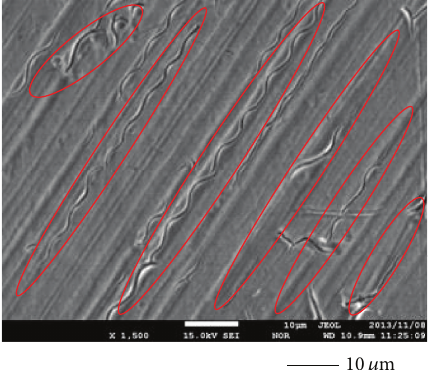
Figure 8: SEM image of TiO 2 film coated on Cu disc.